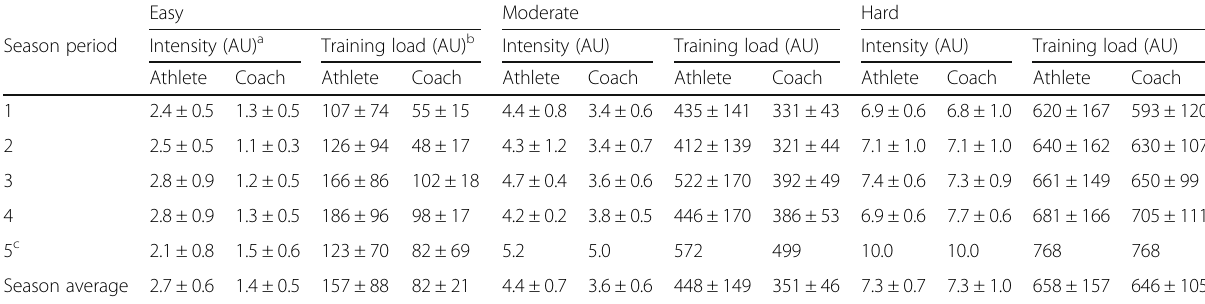
Table 2 Male Runners and Coach ’ s Intensity (sRPE and sRIE) and Training Load (TL RPE ) According to the Season Period and Intended Session Intensity (mean ±